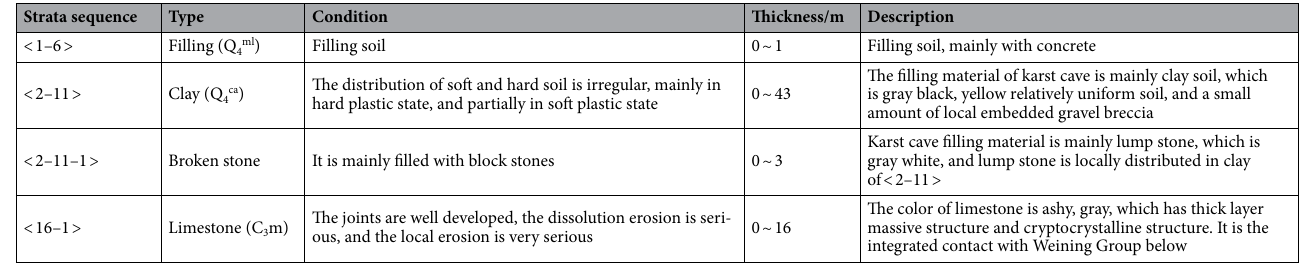
Table 1. The strata information of Changqingpo Tunnel from DK483 + 978 to DK483 + 907.